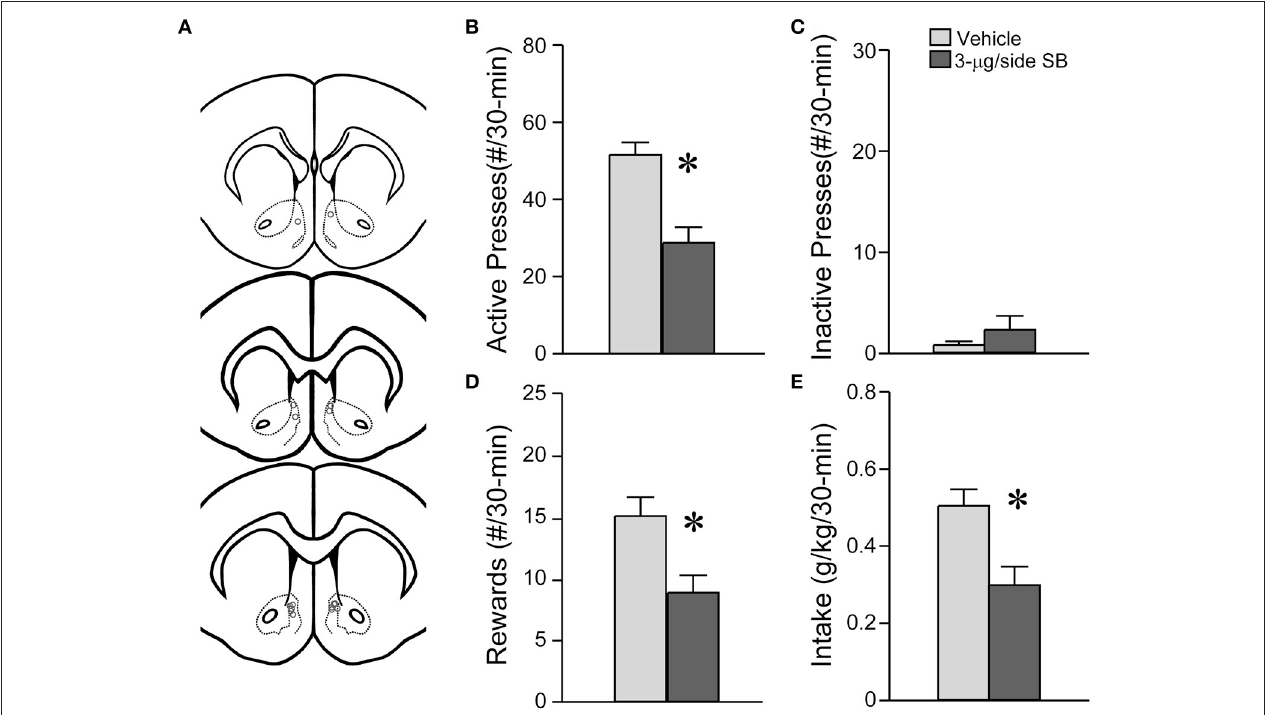
FIGURE 7 | OX1R blockade within the medial NAc Shell significantly reduced operant alcohol drinking in rats. (A) Locations of cannulae shown by gray circles; sections at approximately AP + 1.70, + 1.60, and + 1.20 relative to Bregma. (B) Infusion of 3- µ g SB within the mNAsh of rats decreased active lever presses for alcohol. (C) No changes in inactive lever presses with SB. (D,E) OX1R inhibition in the mNAsh reduced (D) rewards received and (E) alcohol intake levels. * p <